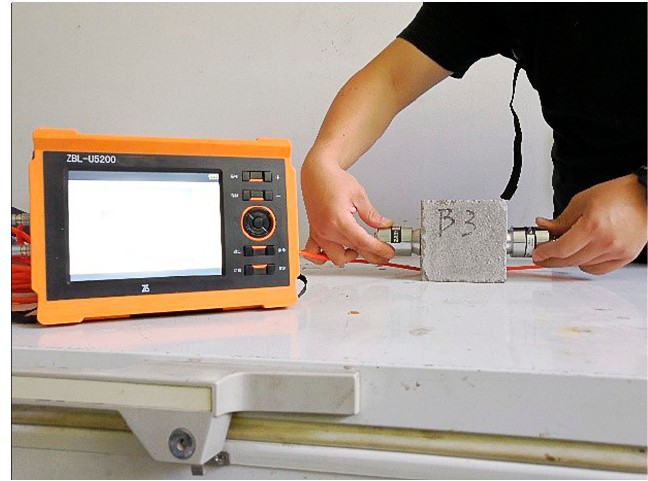
Figure 10. The measurement of ultrasonic pulse velocity of concrete specimen. The “ZBL-U5200” device was adopted to measure the UPV of the concrete specimen. The measurement of UPV was carried out immediately after the specimen left the curing condition to ensure the stability of its moisture content and other states. The transducers were placed on two parallel surfaces of the specimen, with the Vaseline coupling between the transducers and the specimen. Five measuring points were designed on two parallel surfaces, with three instances of measurements on each measuring point. The ultrasonic pulse velocity detection test adopts the direct transmission, as shown in Figure